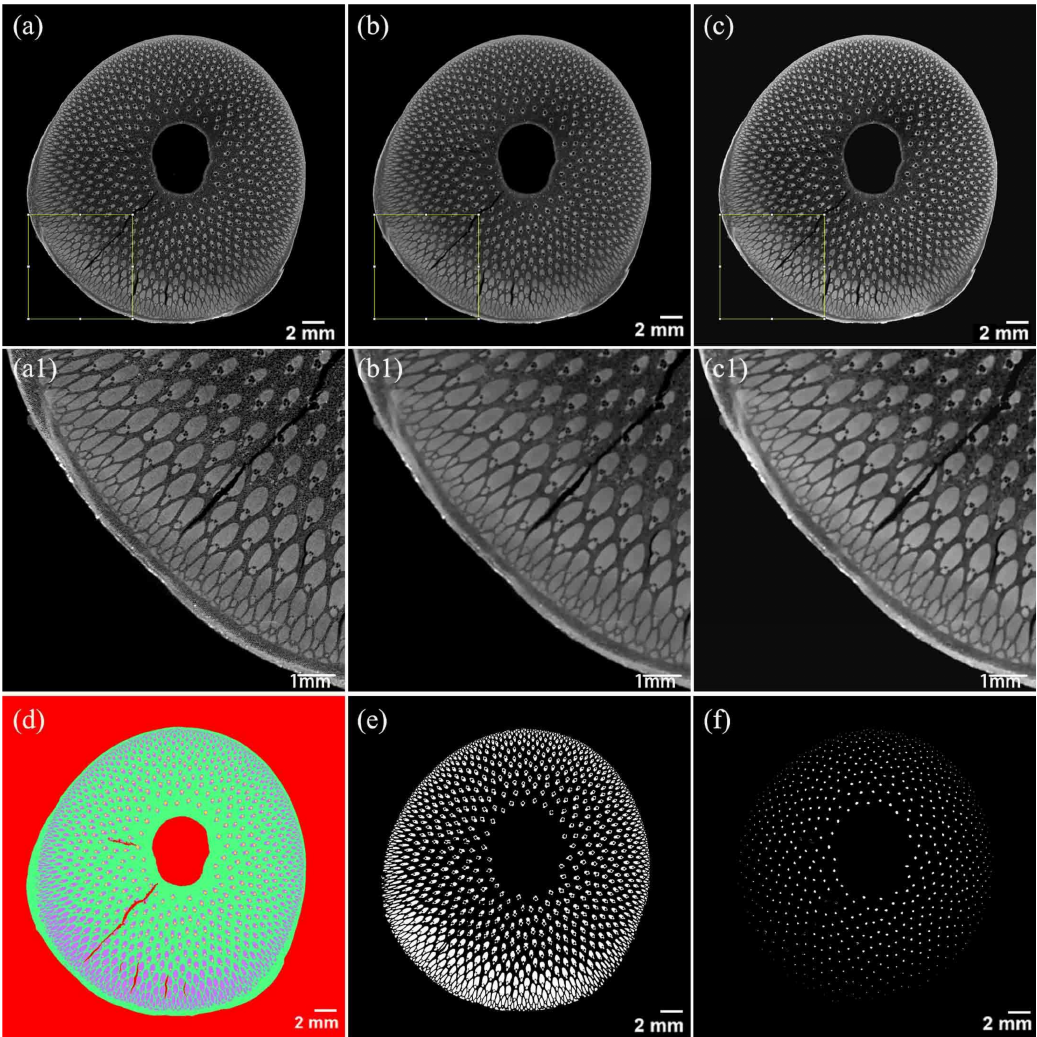
Figure 2. Image processing of µ CT. ( a ) Original µ CT slice and its details ( a1 ). ( b ) Filter processing and its details ( b1 ). ( c ) Contrast adjusting and its details ( c1 ). ( d ) Segmentation of the conducting tissue (yellow), fibers (purple), parenchyma (green), and air (red). ( e ) Binary images of fibers. ( f ) Binary images of conducting